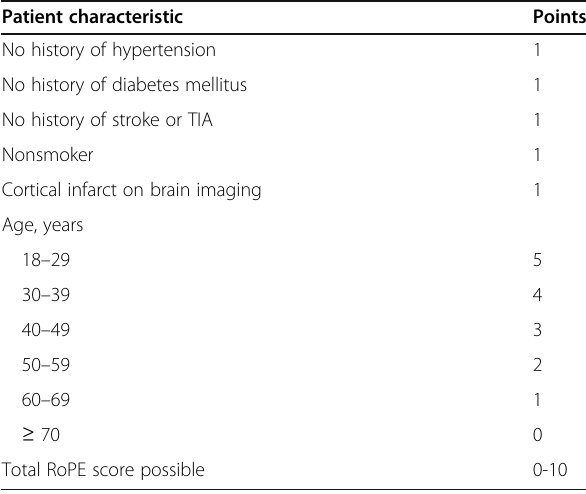
Table 1 Risk of Paradoxical Embolism Score (RoPE)